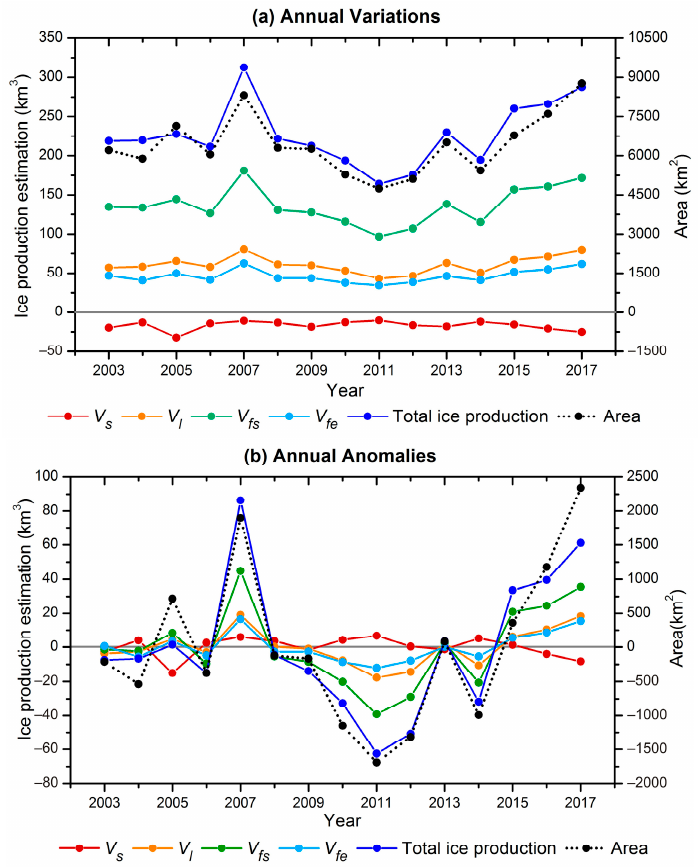
Figure 2. Annual variations ( a ) and anomalies ( b ) of polynya area, ice production and its four components, V s , V I , V fs and V fe . Annual polynya area is the average daily area from April to October. Annual ice production is the sum of daily ice production from April to October, similar for V s , V I , V fs , V fe . The annual anomalies in ( b ) equal values in ( a ) minus the 15-year averaged values.